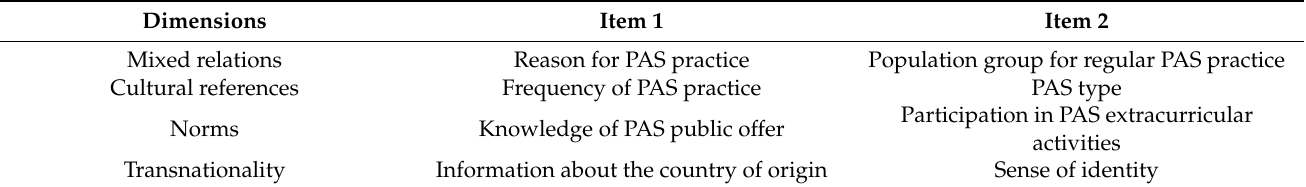
Table A2. Dimensions and variables of the